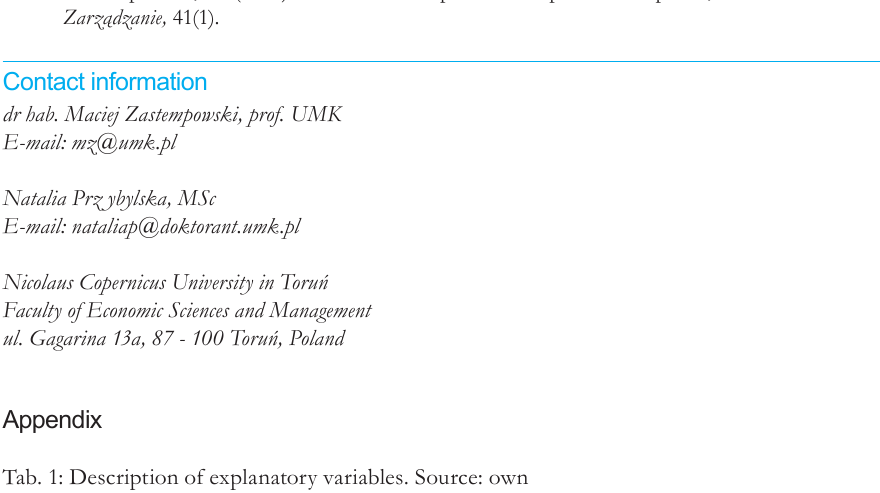
Tab. 1: Description of explanatory variables. Source: own WEB2.0